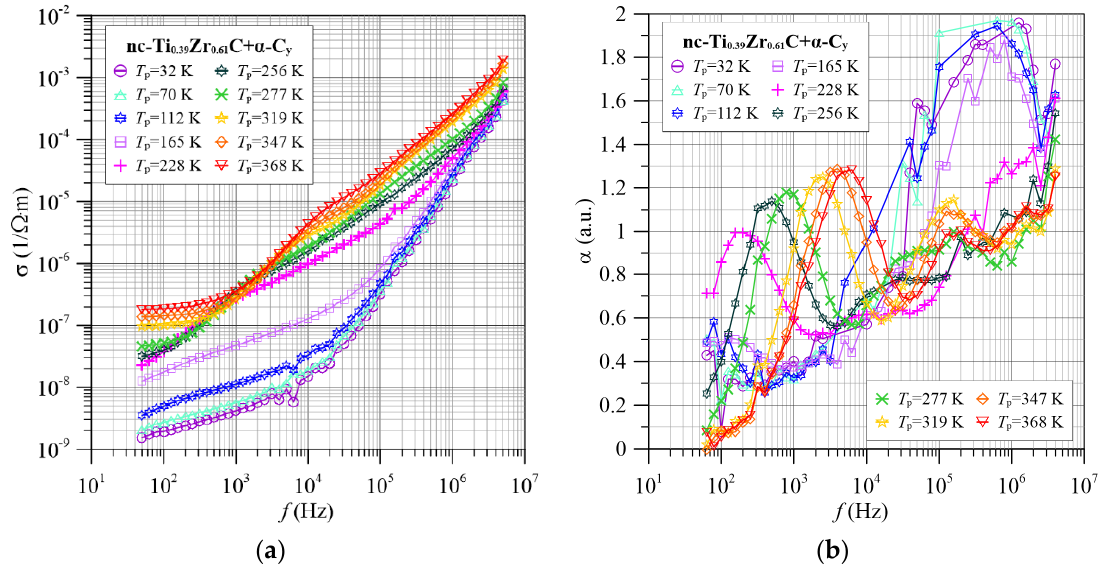
Figure 7. Frequency dependence of conductivity ( a ) and frequency factor α ( f ) ( b ) for selected measurement temperatures for the nc ‐ Ti 0.39 Zr 0.61 C+ α‐ C y nanocomposite.